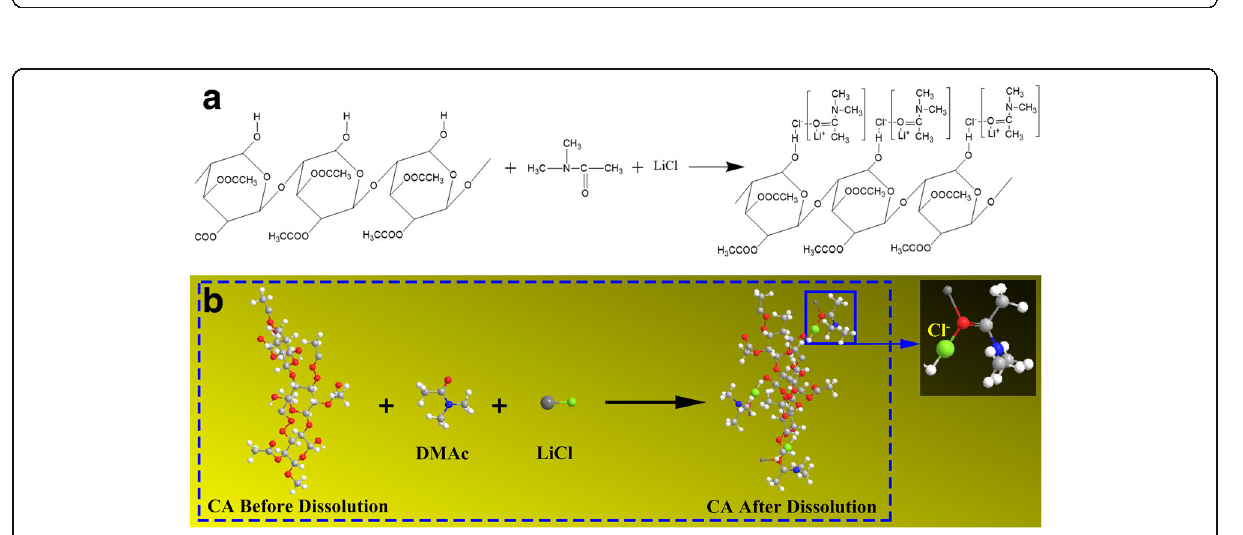
Fig. 4 SEM images of two component systems of CA/TPU1 and CA/TPU2, in which the LiCl added in CA solution is from zero to 2 wt%. The processing condition is of 20 kV applied voltage, 15 cm working distance, and 0.15 ml/h flow rate for both component solutions